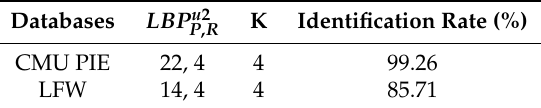
Table 1. Identification rate.